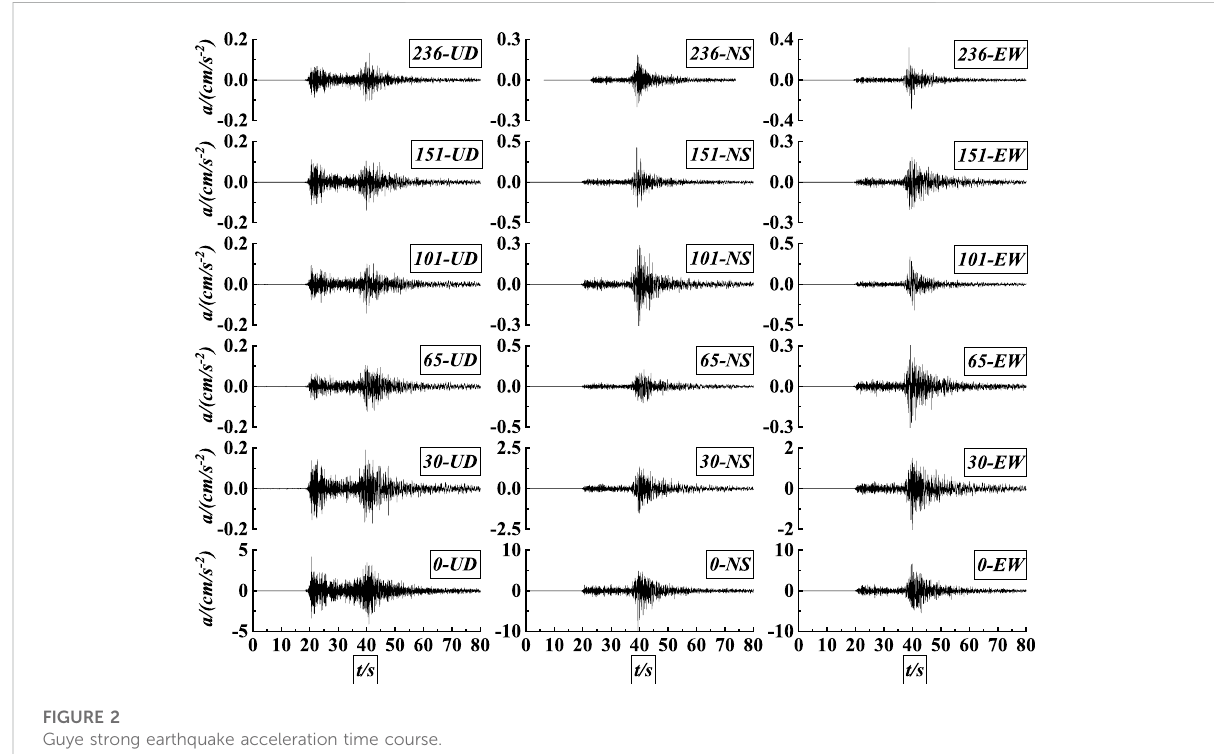
FIGURE 2 Guye strong earthquake acceleration time course.